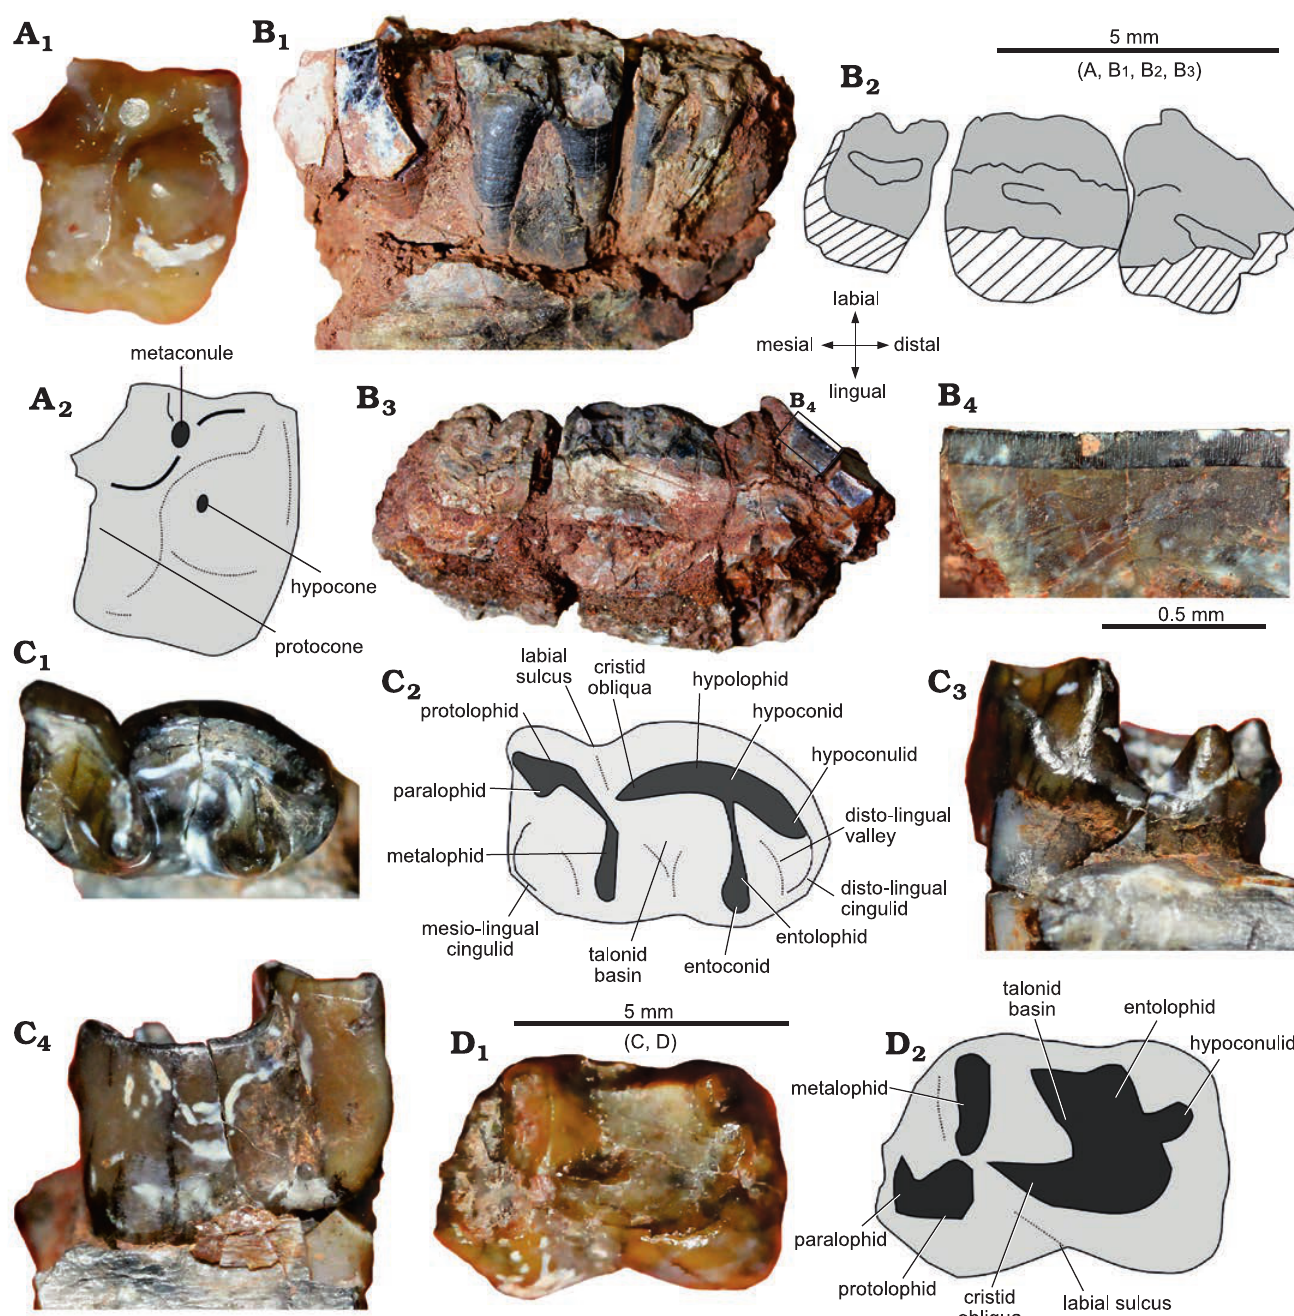
Fig. 1. New fossil materials of Litopterna, Astrapotheria, and Notostylopidae from the Quebrada de Los Colorados Formation exposed at Quebrada Grande locality, Los Cardones National Park (Salta Province), Casamayoran SALMA, Eocene. A . cf. Ernestokokenia sp. (IBIGEO-P 65), fragmented left upper cheek tooth in occlusal view. B . Astrapotheria indet. (IBIGEO-P 66), left maxillary fragment with three broken molariforms in lingual (B 1 ) and occlusal (B 3 ) views, and detail showing Hunter-Schreger bands (B 4 ); dashed area in B 2 indicates broken or missing dental areas. C . Homalostylops sp. (IBIGEO-P 57b), right m2? in occlusal (C 1 ), lingual (C 3 ), and labial (C 4 ) views. D . ? Homalostylops sp. (IBIGEO-P 57a), left m1? in occlusal view. Photographs (A 1 , B 1 , B 3 , B 4 , C 1 , C 3 , C 4 , D 1 ), explanatory drawings (A 2 , B 2 , C 2 , D 2 Material .—IBIGEO-P 57b, right m2?, Quebrada Grande, Los Genus Homalostylops Ameghino, 1901 Cardones National Park, Casamayoran SALMA, Eocene. Type species : Homalostylops rigeo Ameghino, 1901; Gran Barranca, Chubut Province, Argentina; Casamayoran SALMA, Eocene. Description .—IBIGEO-P 57b is a low-crowned tooth, more Homalostylops sp. brachydont than in species of Boreastylops , and subrectan- gular in outline, being more mesio-distally expanded (i.e., Fig. 1C.